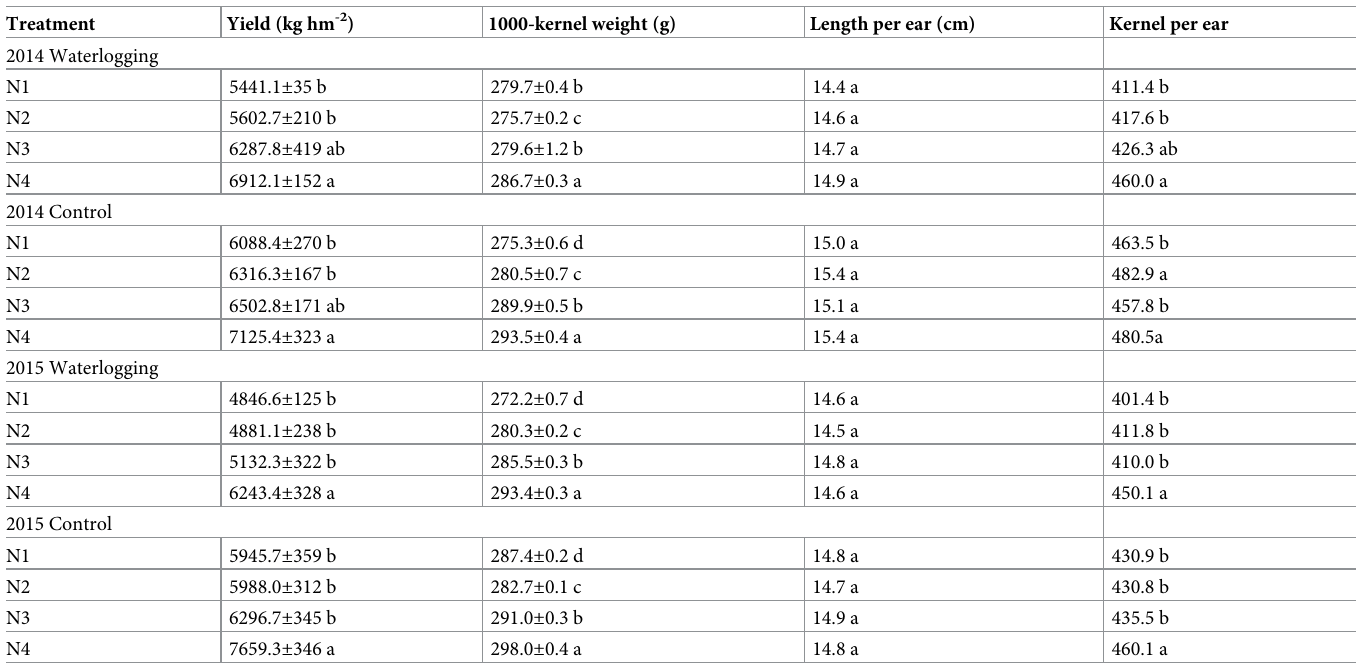
Values followed by different letters are significantly different ( p < 0.05) among different N treatments. N1: 100% N applied as basal fertilizer, N2: 70% N applied as basal fertilizer and 30% N applied at the jointing stage, N3: 50% N applied as basal fertilizer and 50% N applied at the jointing stage, N4: 30% N applied as basal fertilizer, 50% N applied at the jointing stage and 20% N applied at the big flare